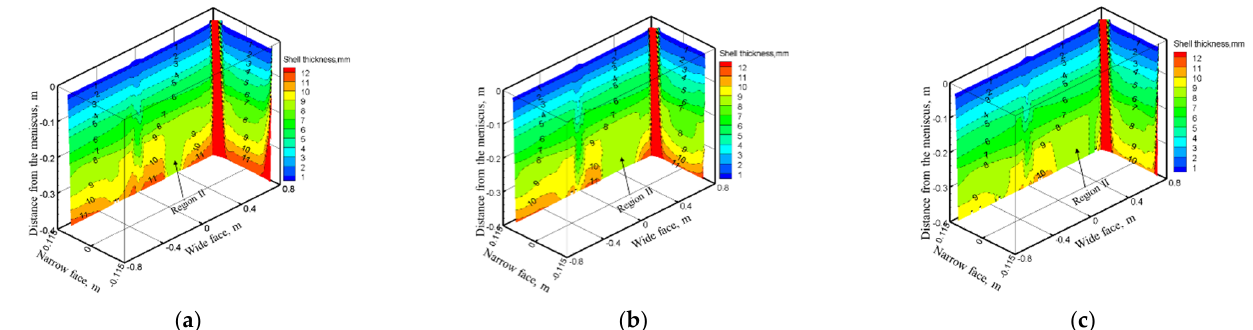
Figure 12. 3D variation of solidified shell thickness along the casting direction under different casting speeds at (600 A, 4 Hz): ( a ) 0.8 m/min, ( b ) 1.2 m/min, ( c ) 1.4 m/min.